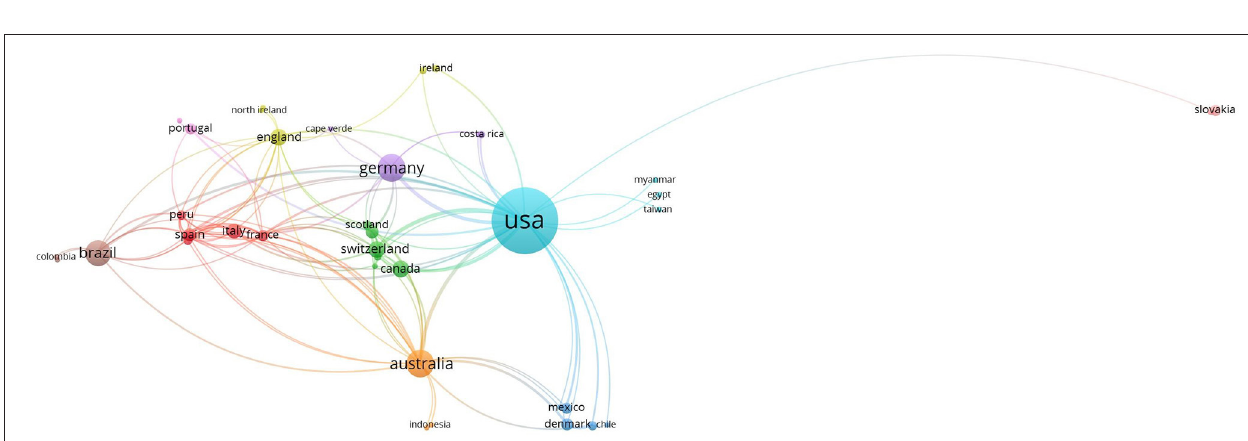
FIGURE 3 | Diagnostic methods used in different studies from inception 1970 to September 8, 2020. Of the 130 studies extracted for this quantitative analysis, 22 (17%), 59 (45%), 36 (28%), 24 (18%), and 87 (67%) used virus isolation, histopathology, electron microscopy, serology, and nucleic acid detection assays, respectively, for various investigations of reptilian HVs.